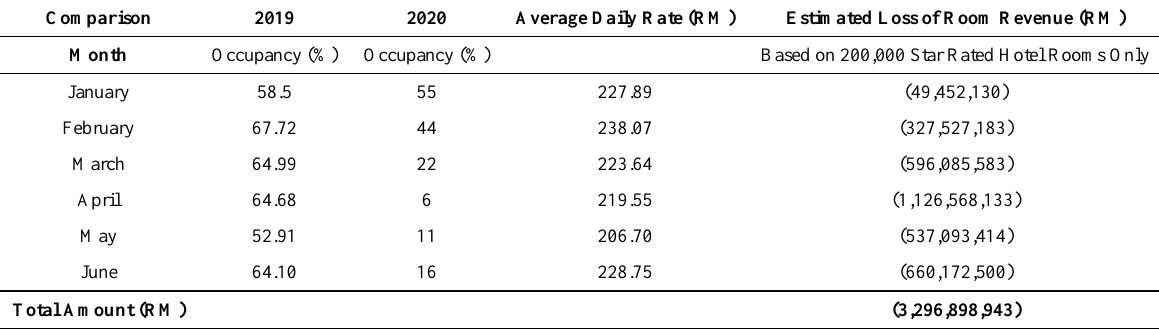
Table 4. Malaysia’s Hotel Occupancy Comparison for 2019 vs.